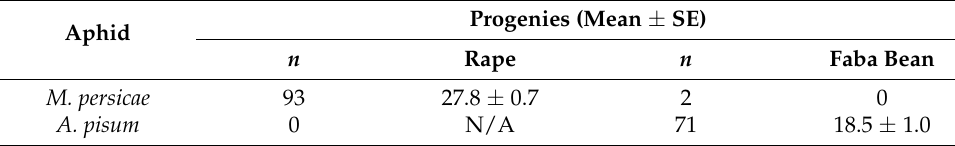
Table 4. Fecundity of M. persicae and A. pisum reared on rape versus on faba bean.